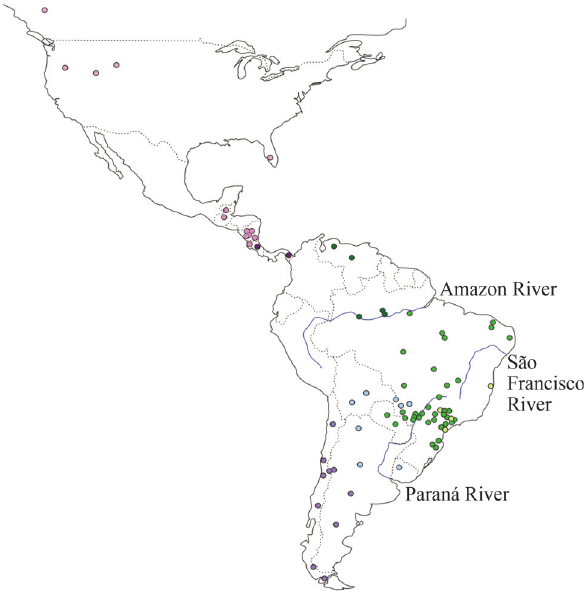
Figure 1 - Geographic distribution of the Puma concolor samples ana- lyzedhere.Bluelinesindicatethreemajorrivers.Thedifferentcolorsindi - catethesevengroupsidentifiedwiththeAMOVA(seetextandTable3for details): Northern Central America + North America (NCA+NA, in light pink), Southern Central America (SCA, in dark pink), Northern South America (NSA, in dark green), Central-North-Eastern South America (CNESA,inmediumgreen),EasternSouthAmerica(ESA,inlightgreen), Central-Southern South America (CSSA, in light blue) and Southwestern South America (SWSA, in